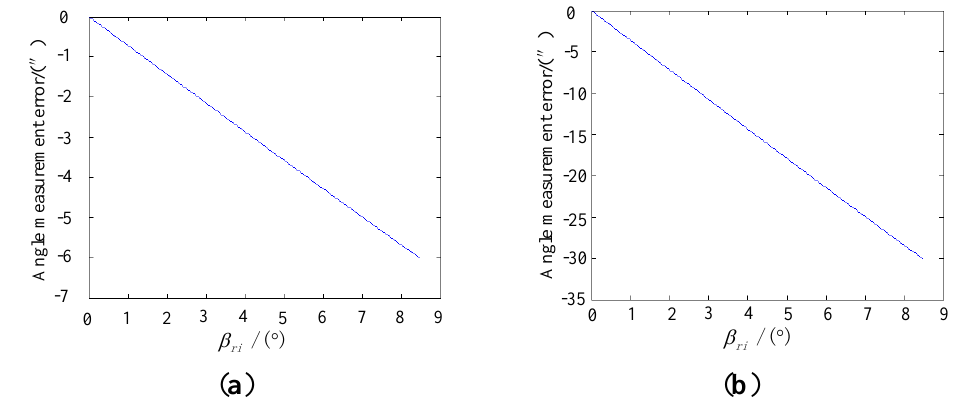
Figure 8. Influence of the distortion on the star sensor accuracy. ( a ) is obtained when the relative distortion is approximately 2/10,000th; and ( b ) is obtained when the relative distortion is approximately